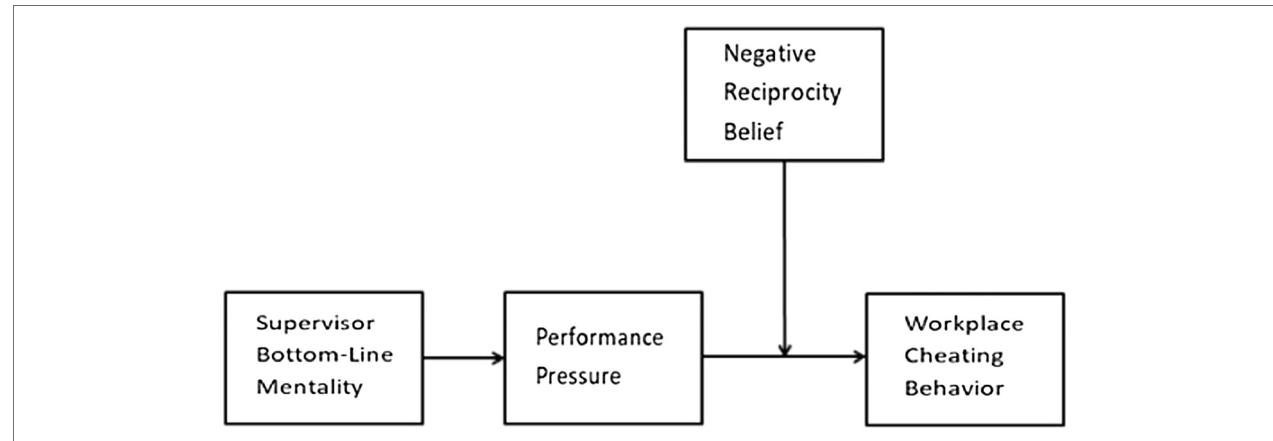
FIGURE 1 | Conceptual